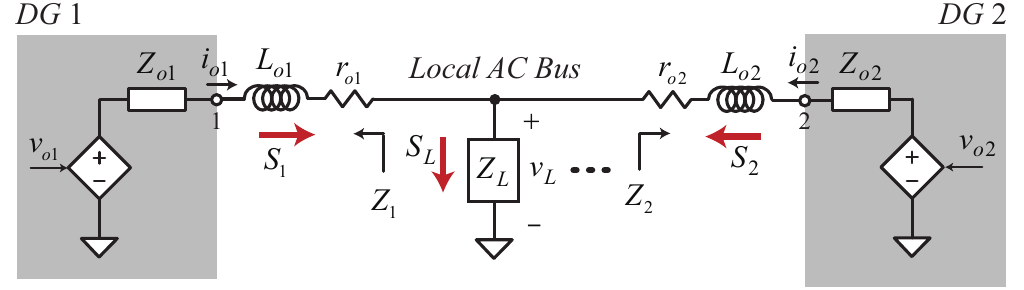
Figure 2. Equivalent circuit diagram of inverter-based